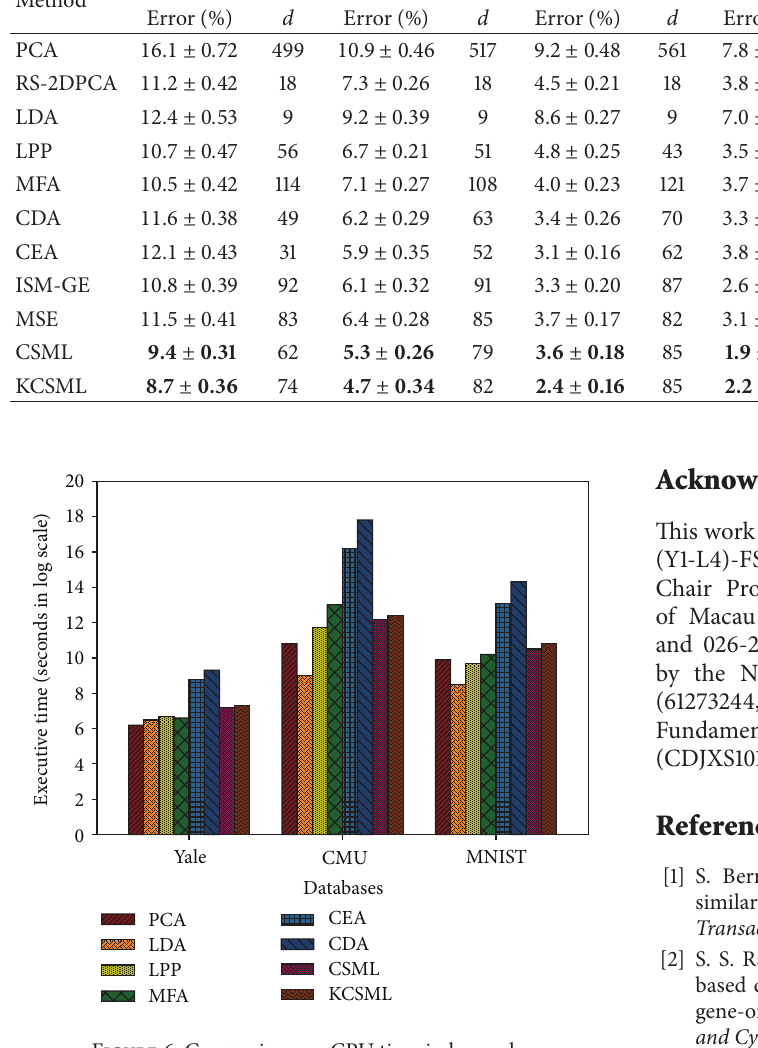
Figure 6: Comparison on CPU time in log